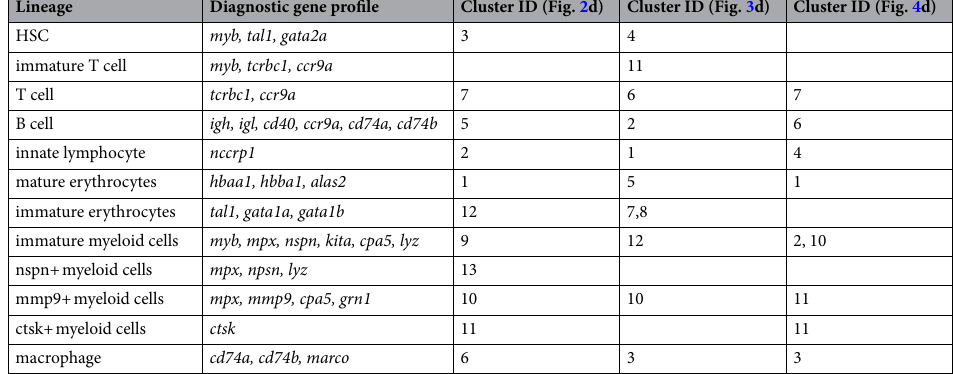
Table 2. Gene expression profiles of haematopoietic lineages identified by scRNA of WKM marrow